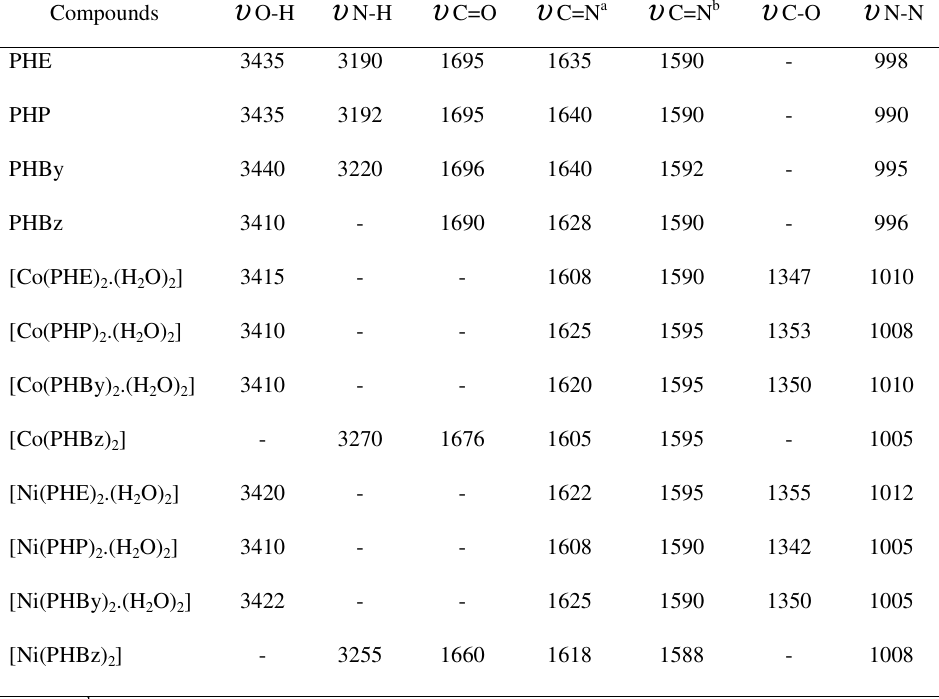
Table 2 . Important IR spectral data (cm -1 ) of hydrazone ligands and its Co II and Ni II